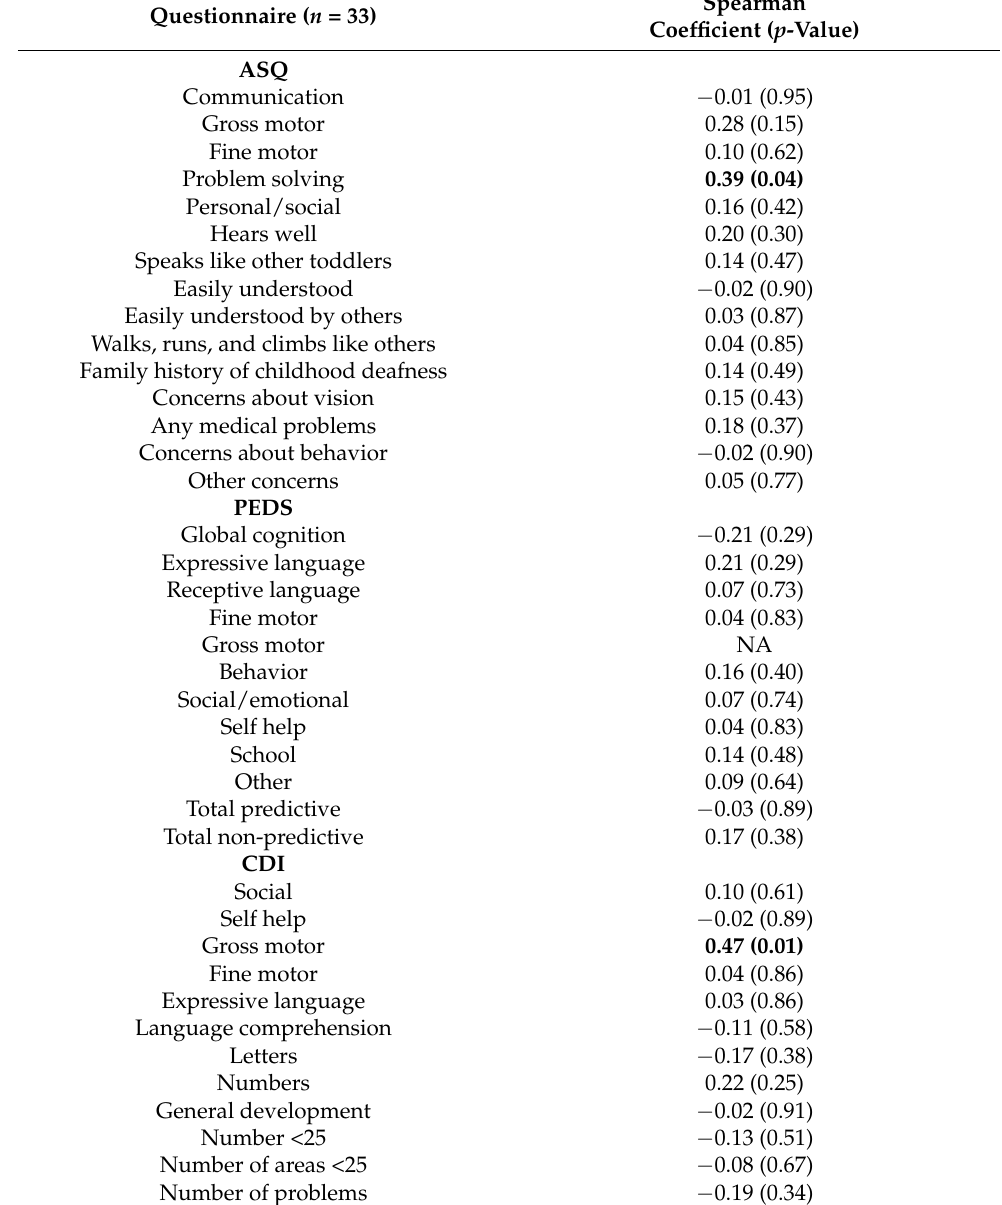
Table A4. Partially adjusted correlation between breastfeeding category and questionnaire score.